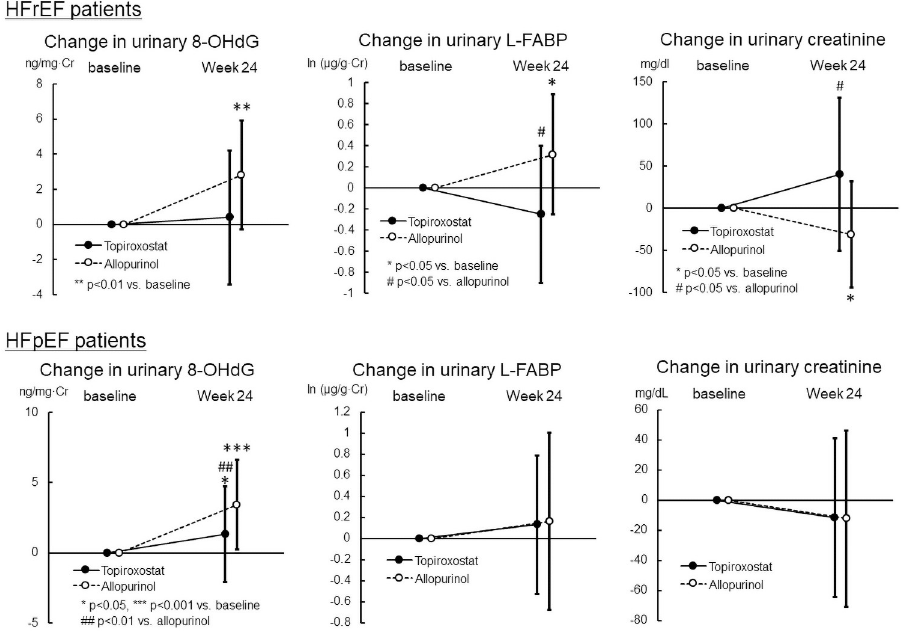
Fig 4. Changes in urinary 8-OHdG, L-FABP and creatinine levels in each HFrEF and HFpEF patients (FAS). Values are mean ± standard deviation. For the changes in the values 24 weeks from baseline were assessed using the paired Student’s t-test in each group. For the difference between both groups analyzed using the unpaired t-test.